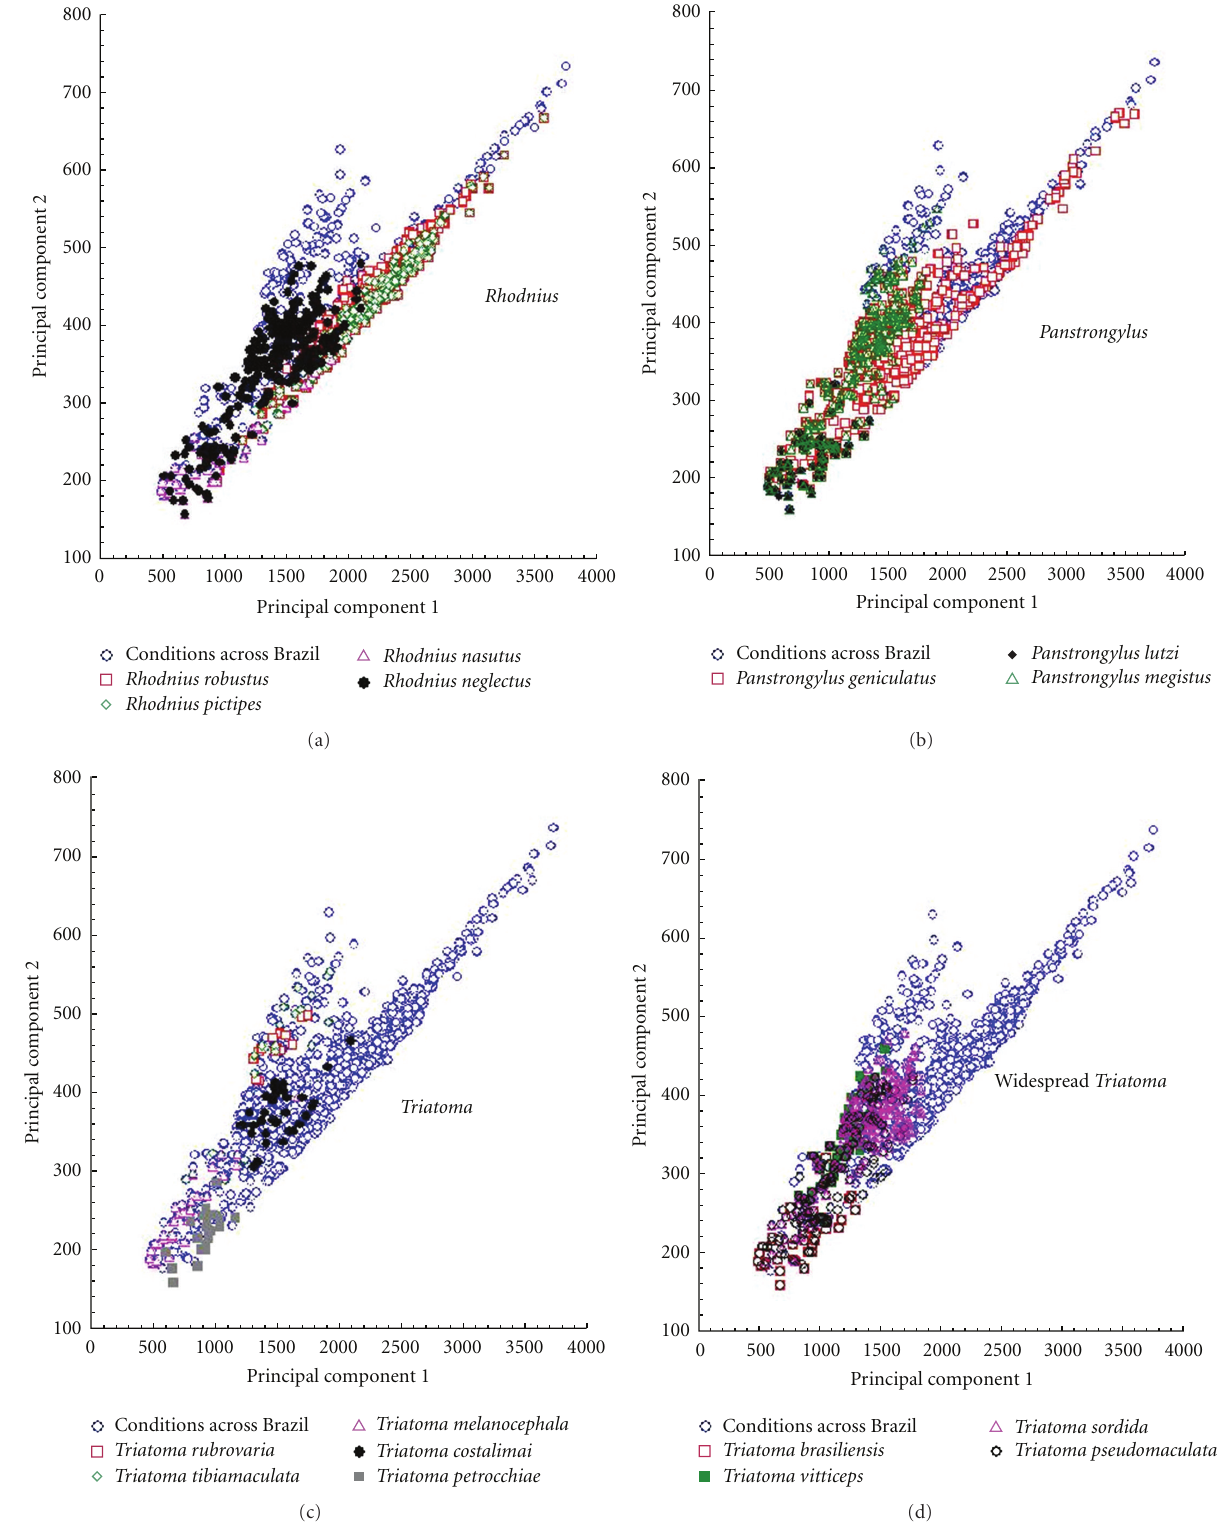
Figure 9: Distribution of 16 triatomine species in Brazil with respect to environmental variation summarized as the first two principal components summarizing variation in seven climatic dimensions. To provide a view of species’ responses to environmental variation across Brazil, we plotted 1000 random points across the country, and assigned to each (1) the predicted presence or absence of each species and (2) the values of the first two principal components extracted from the bioclimatic data